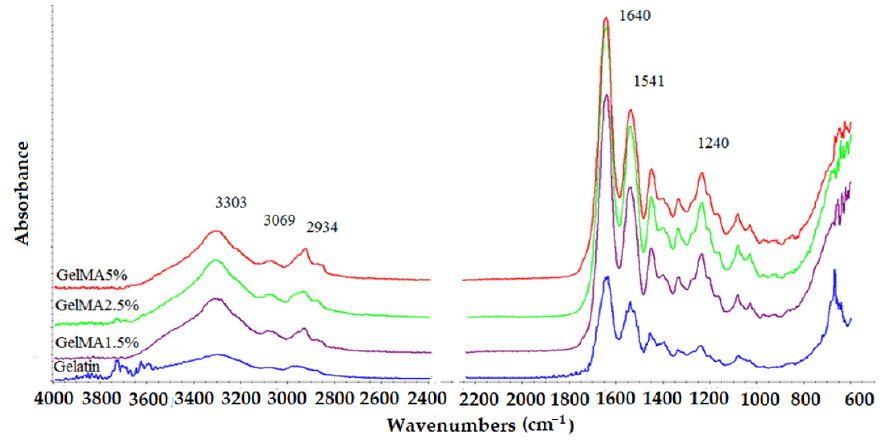
Figure 3. FTIR spectra of gelatin, GelMA1.5%; GelMA2.5%; GelMA5%.